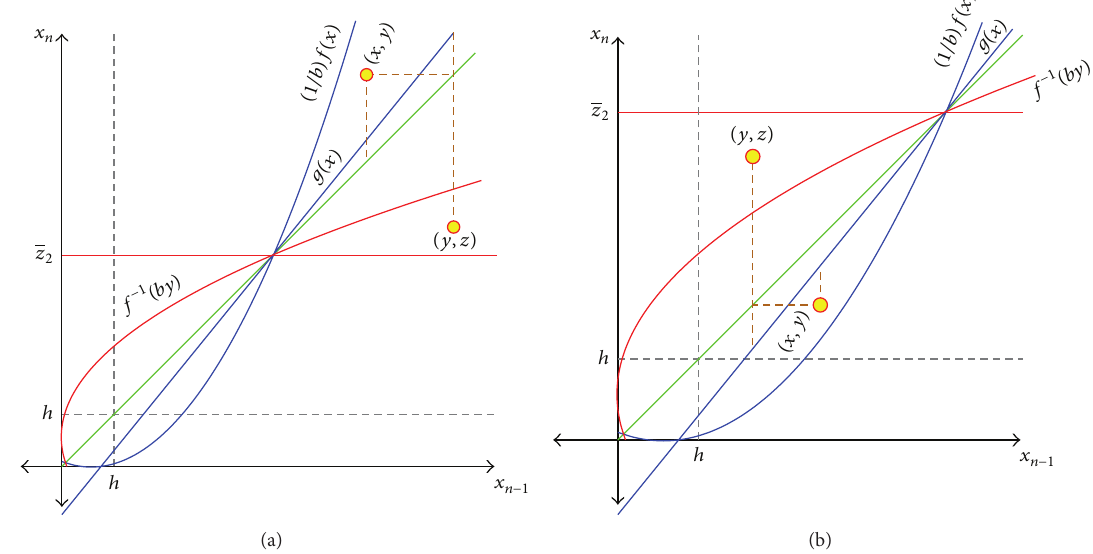
Figure 1: (a) clarifies the proof of Case 1 while (b) clarifies the proof of Case 2. The scale on the axes is intentionally missing because the graphs represent the general situation.